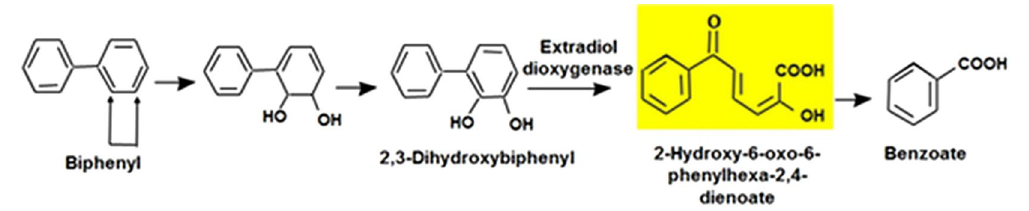
Figure 5. Metabolism of biphenyl via lateral dioxygenation and the biphenyl upper pathway, and the yellow product as a result of extradiol dioxygenase (2,3-dihydroxybiphenyl 1,2-dioxygenase)